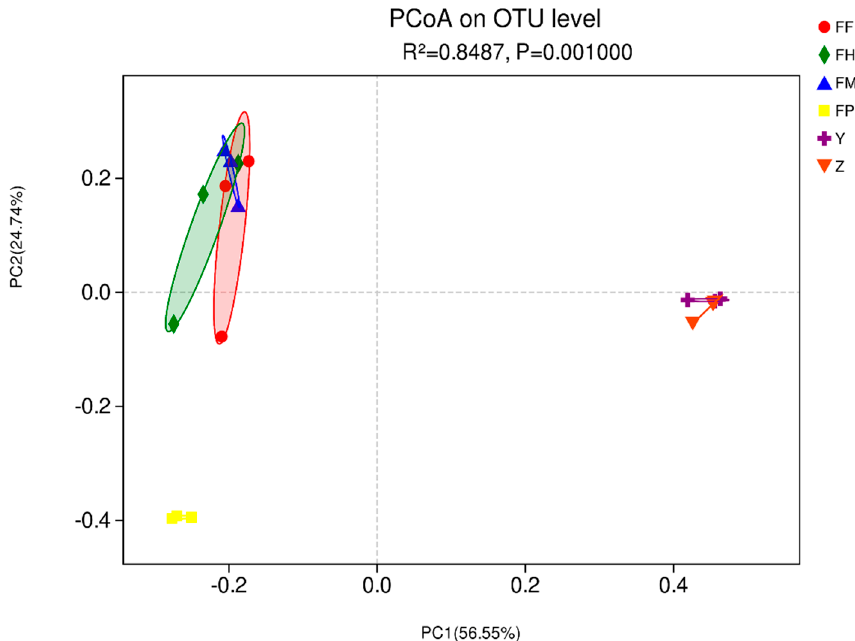
Figure 3. Beta-diversity of microbial communities in intestine samples of M. alternatus and tissue samples of P. massoniana . Principal Coordinates Analysis based on unweighted unifrac distances generated from operational taxonomic units (out) tables. Ellipses of different colors represent different groupings. (PERMANOVA; p = 0.001).